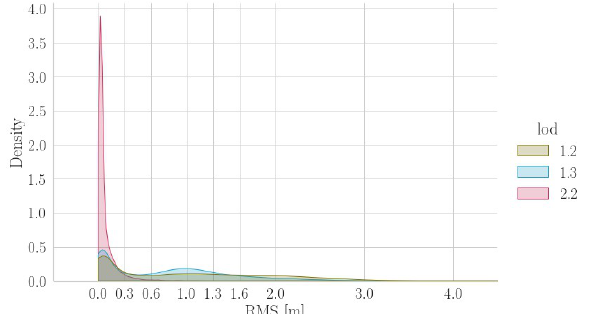
Figure 8 . Root Mean Squared distances from points to model, per Level of Detail. Values in meters.